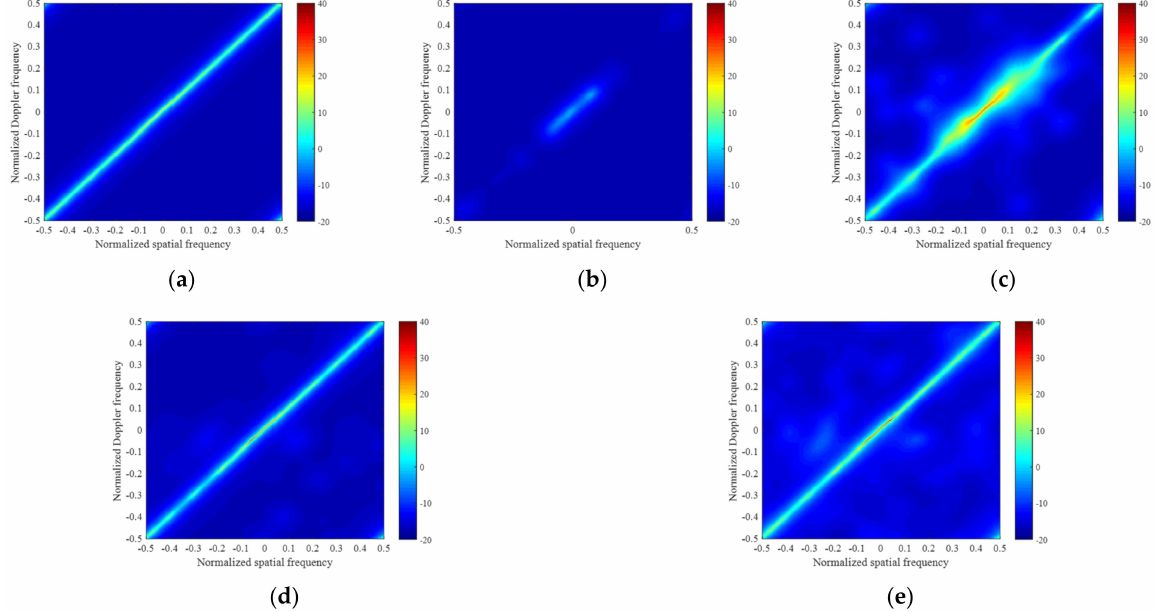
Figure 4. Angle-Doppler clutter power spectrums in the non-ideal case with array errors: ( a ) exact spectrum calculated by the exact CNCM; ( b ) sparse spectrum estimated by LSMI; ( c ) sparse spectrum estimated by M-OMP-STAP; ( d ) sparse spectrum estimated by M-SBL-STAP; and ( e ) sparse spectrum estimated by